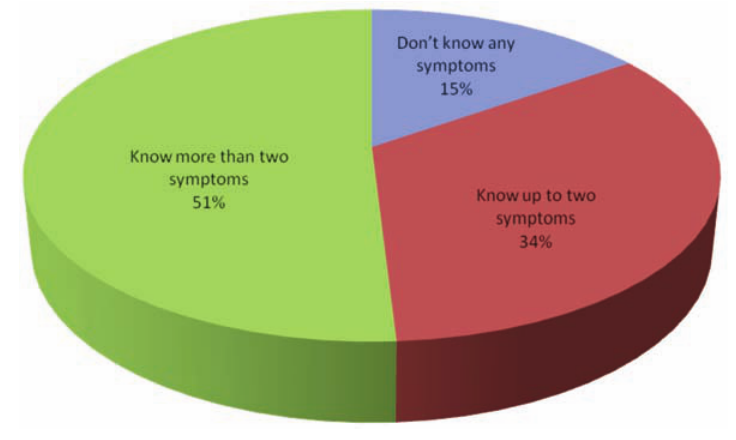
Figure 1. Knowledge of malaria symptoms among pregnant women attending antenatal services at Federal Medical Centre, Makurdi, Benue State,